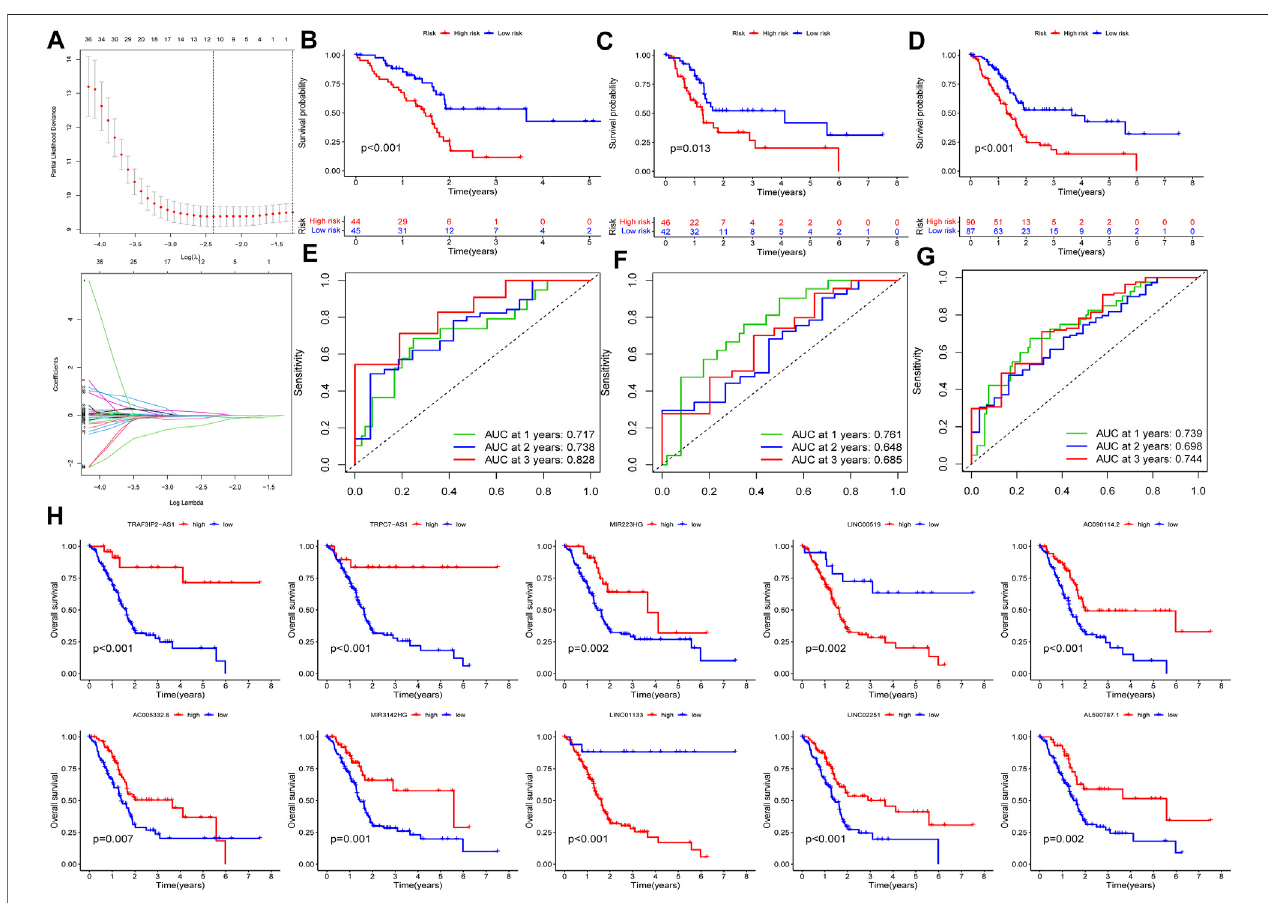
FIGURE 5 | Construction and validation ofPRlncRNAs riskmodel. (A) Lasso Coxregression analysis. (B – D) K-M survival curvesof patients in the training, testing, and entire dataset. (E – G) Receiver operating characteristic (ROC) curves of three cohorts. (H) Independent prognostic analysis of 10 PRlncRNA risks.